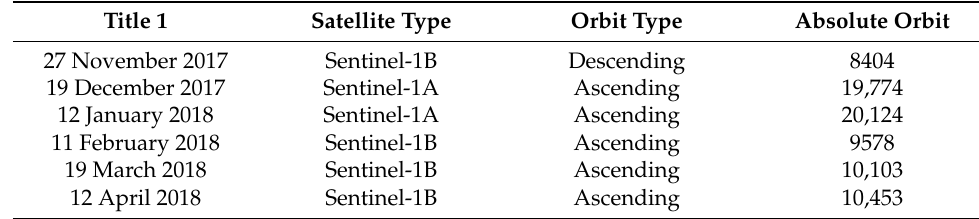
Table 2. Table of used temporal satellite images SAR Sentinel-1 with their